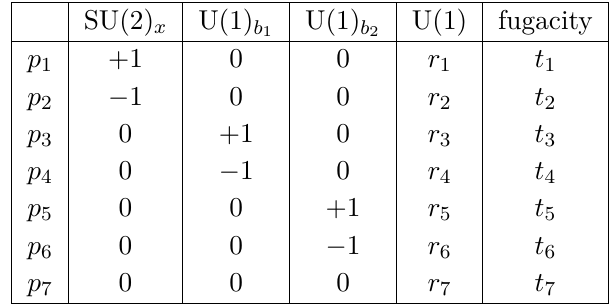
Table 55 . Global symmetry charges on the extremal brick matchings p i of Model